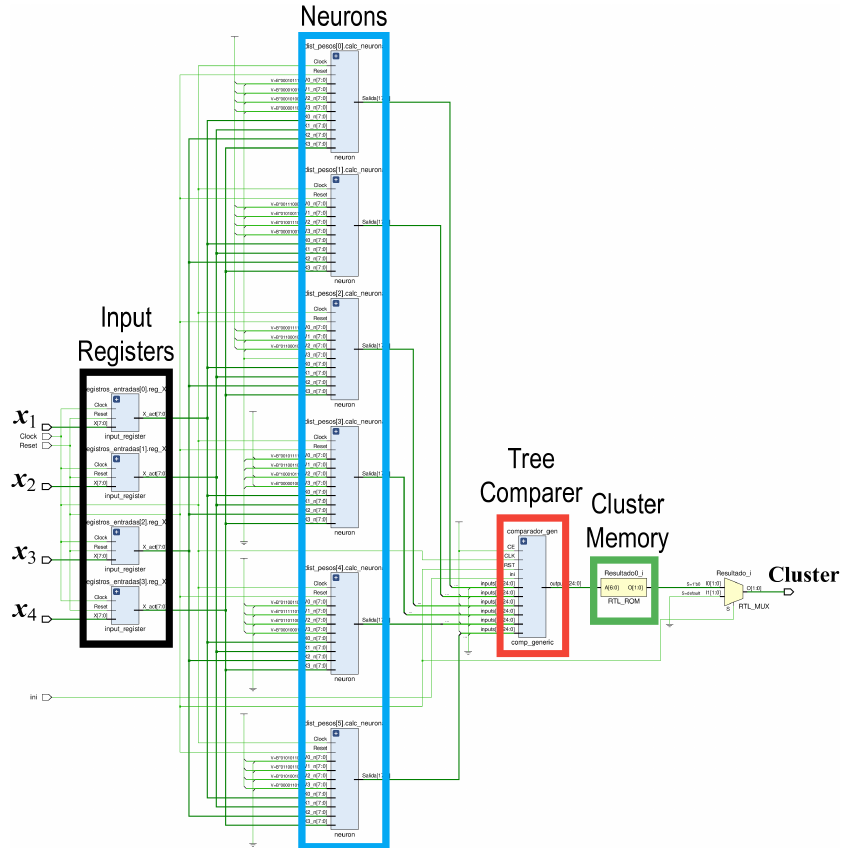
Figure 14. Scheme of the SOM hardware accelerator. A four-input SOM topology with six output neurons is shown as a case